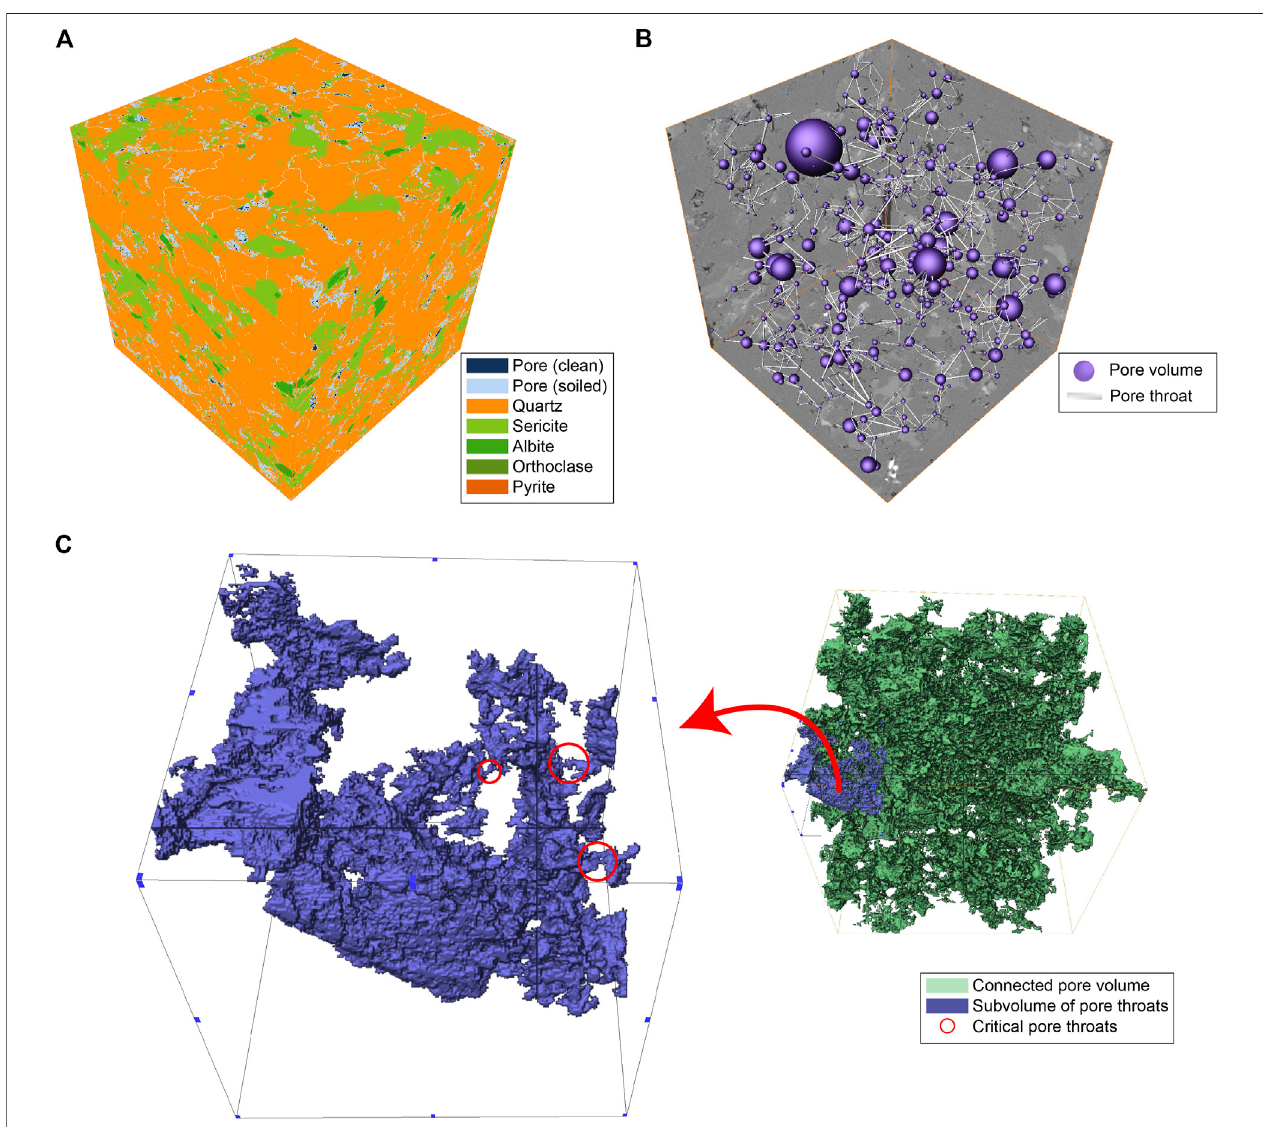
FIGURE 4 | (A) Segmented 800 3 voxel subvolume with additional implemented high angle quartz grain boundaries in a white color. (B) Corresponding connected pore network. The ball sizes are indicating the pore size volumes. Visualized pore throats show the connectivity between two pore volumes. (C) Visualized connected porosity of panel (B) indicating critical pore throats in a subvolume. All fi gures were created with Avizo (2019).